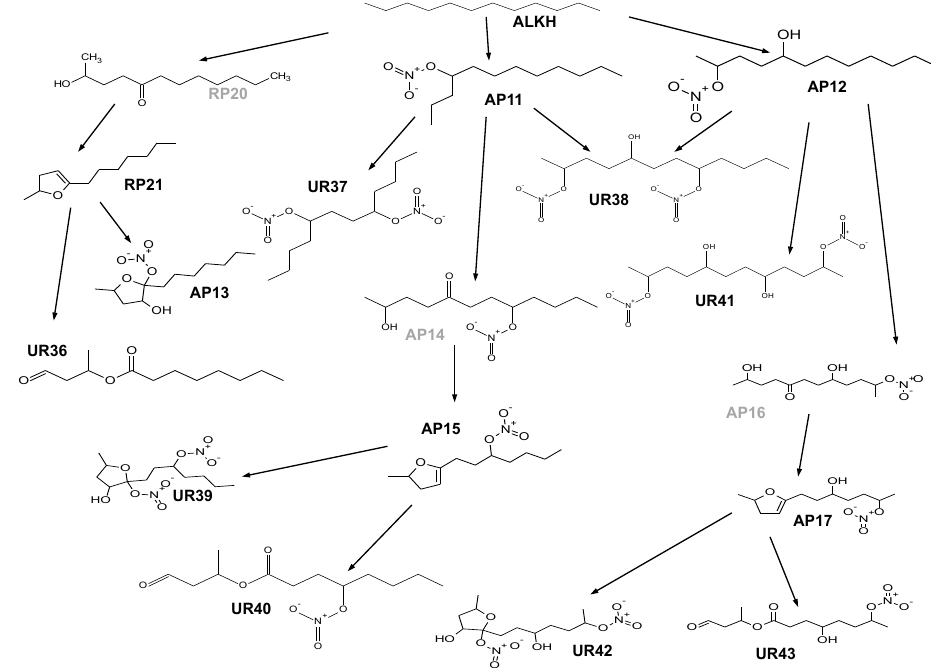
(cid:113) in the presence of NO x as